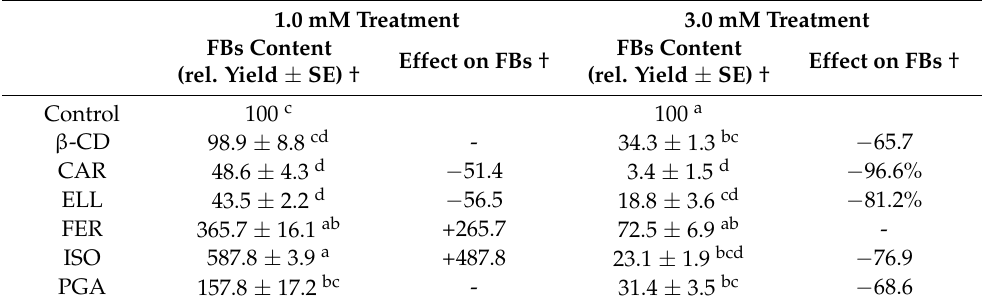
Table 4. Effect of selected phenolic compounds on FBs production in maize